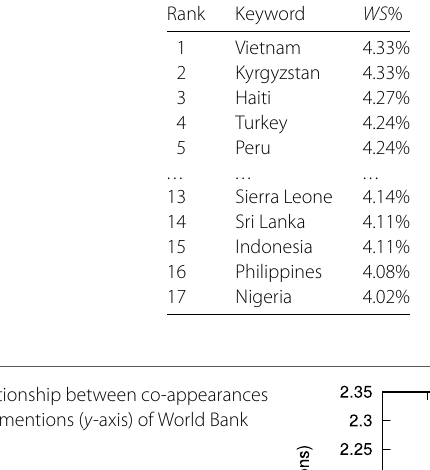
Table 4 The ten most associated countries to the World Bank according to WS Rank